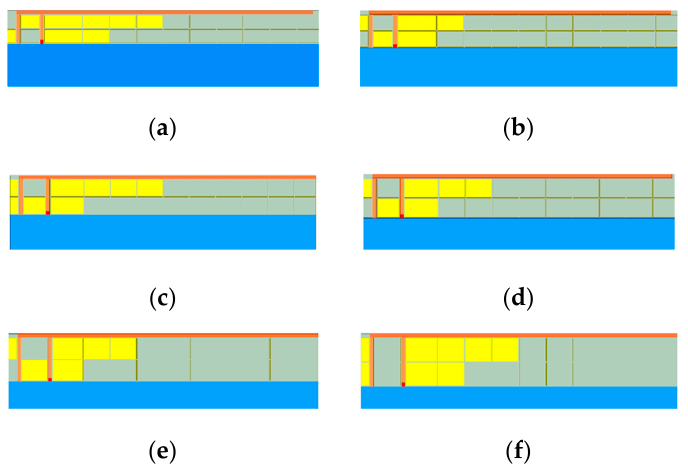
Figure 6. Optimized patch configurations for ground clearances of ( a ) 9 mm, ( b ) 10 mm, ( c ) 11 mm, ( d ) 12 mm, ( e ) 13 mm, and ( f ) 14 mm.